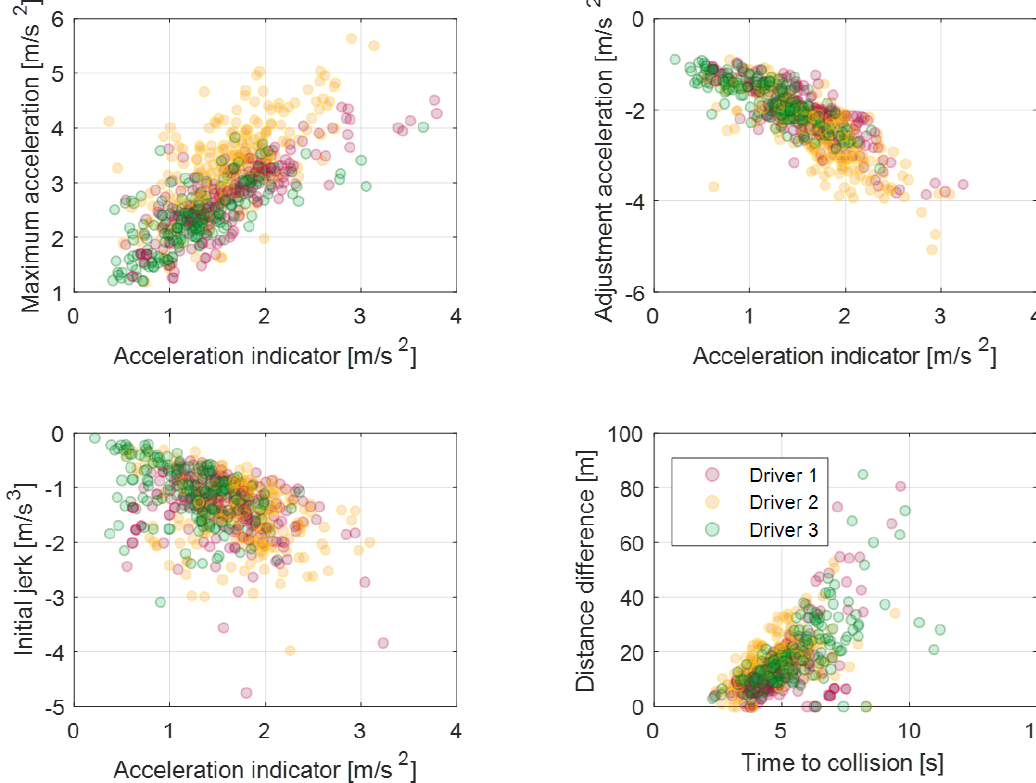
Figure 12. Model parameters and parameter indices for static deceleration